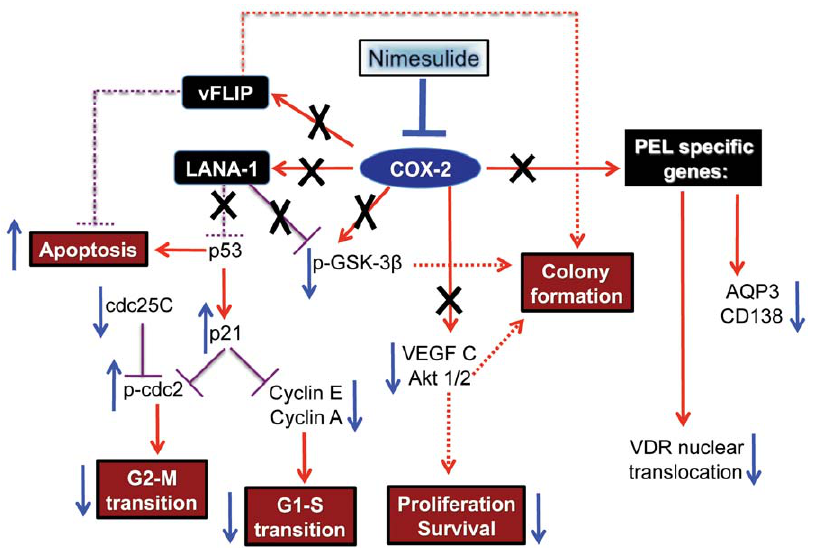
Figure 11. Schematic model representing the mechanistic effect of the COX-2 inhibitor nimesulide on PEL pathogenesis. COX-2 blockade by nimesulide inhibits latency genes LANA-1 and vFLIP. The pro-survival mechanisms that COX-2 provides PEL cells through viral gene independent and dependent pathways, such as proliferation, cell cycle regulation, apoptosis blockade, angiogenesis, and metastasis are blocked by nimesulide through the alteration of cell survival and PEL specific genes as indicated.